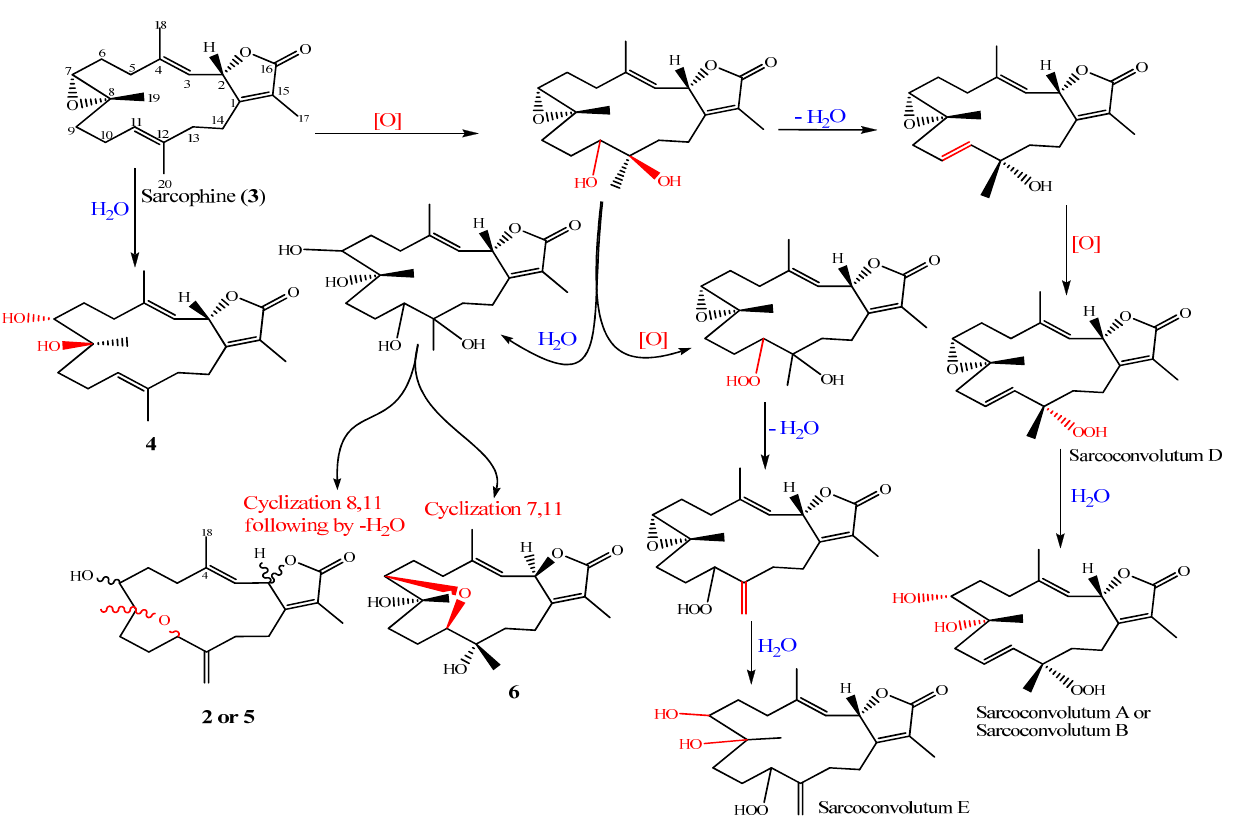
Figure 5. Putative biosynthetic pathways responsible for the synthesis of compounds ( 2 – 6 ) and other reported.